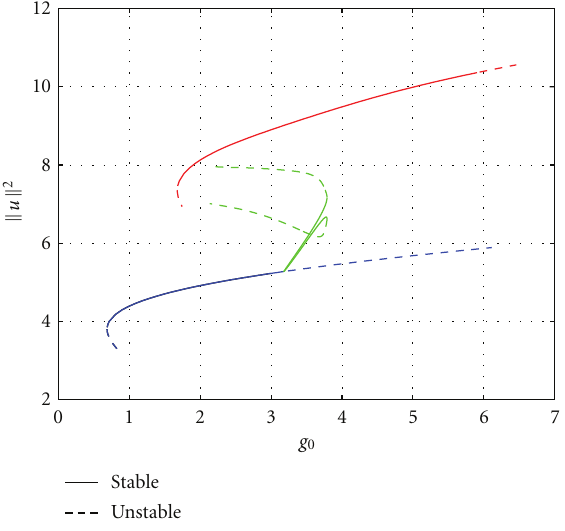
Figure 9: Bifurcation diagram of the total cavity energy of the reconstructed field u as a function of g 0 . Here the bottom branch (blue) represents the single-pulse solution, and the top branch (red) represents the double-pulse solution. The middle branch (green) denotes the extrema of the energy of the periodic